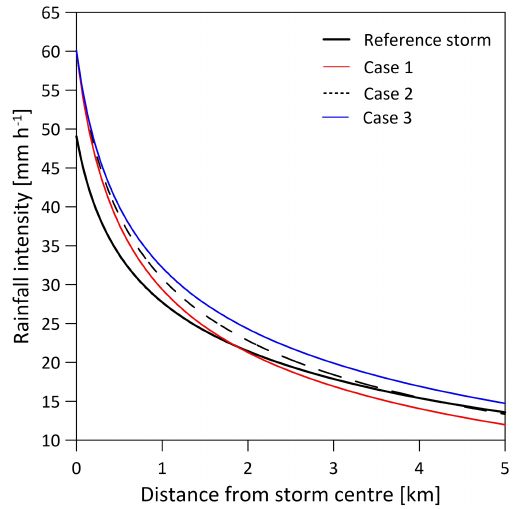
Figure 1. Graph of the changes to the spatial structure of storms with increasing temperature. The peak of the storm is at the storm’s centre and the rainfall intensities follow a log-normal decay with distance from the centre. The black line represents a storm for an arbitrary temperature (reference storm). Other lines (cases 1 to 3) represent plausible storm profiles with higher temperature, which lead to an intensified rainfall peak but differences in areal rainfall and area of heavy rainfall (see text for